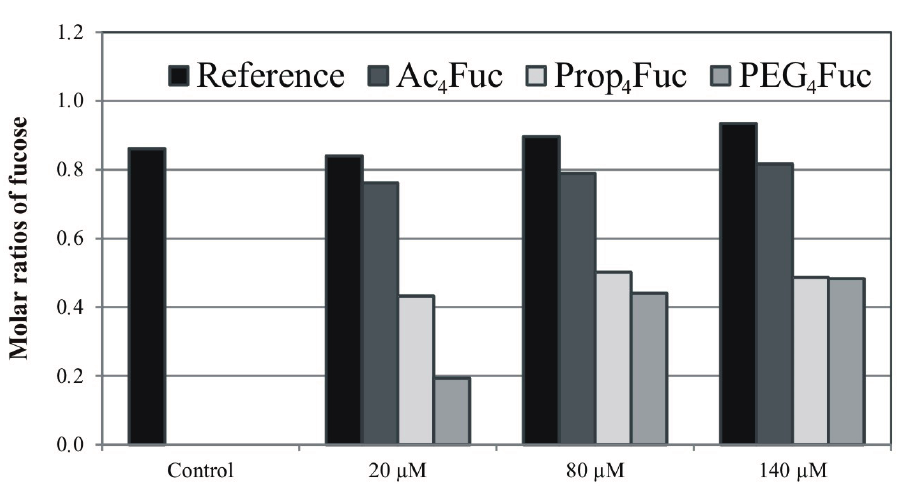
Figure 6. Molar ratios of fucose derived from glycans of recombinant trastuzumab as determined by HPAEC-PAD. CHO RMD cells were treated with varying concentrations of Ac 4 Fuc, Prop 4 Fuc and PEG 4 Fuc (compared to an untreated control) under serum-free conditions for three days. Treatment of parental CHO cells was performed likewise and is exemplarily shown for Ac 4 Fuc (termed as “Reference”). Ratios are given related to mannose = 3 (based on the composition of a N -glycan core